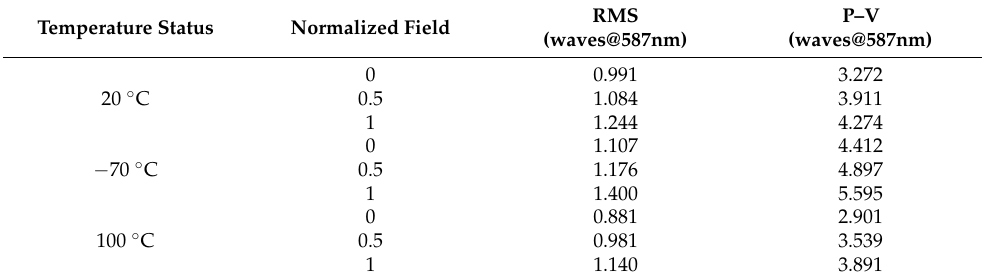
Table 8. Wavefront analysis results of the lens after iteration optimization with different